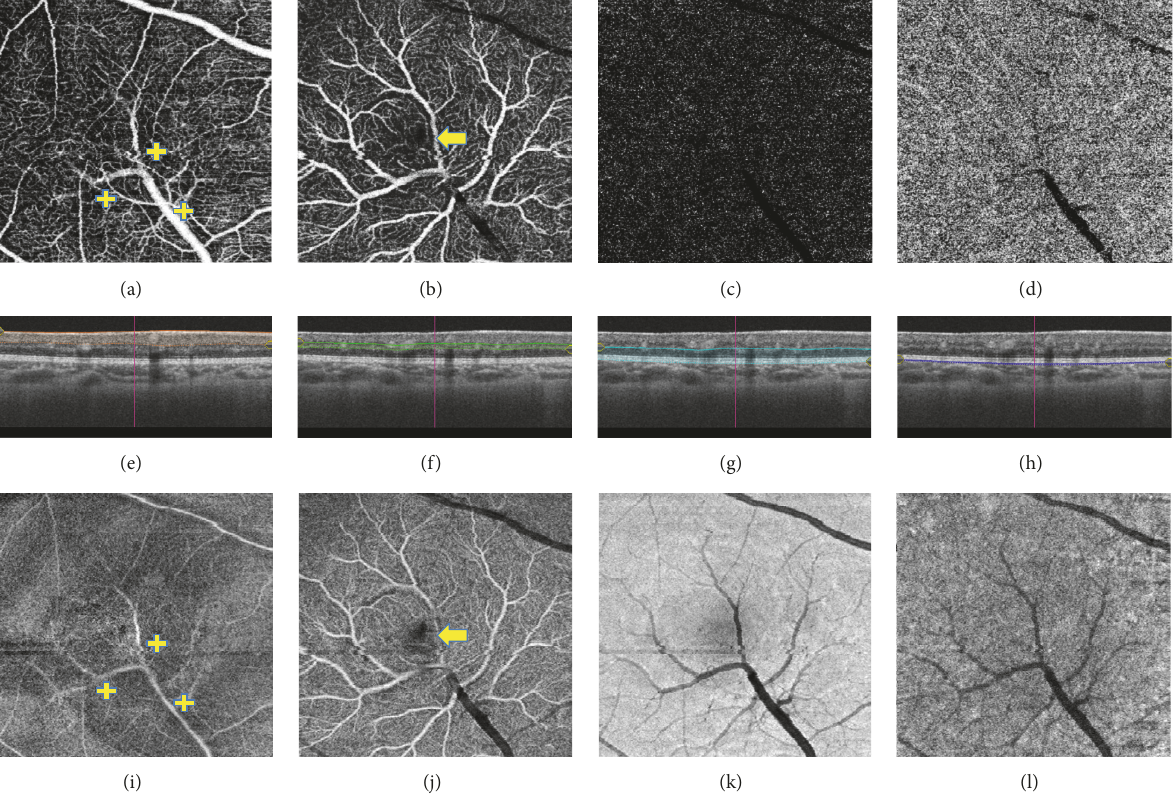
Figure 2: Swept-source OCT angiography (a, b, c, and d) with corresponding segmentation B scan (e, f, g, and h) and en face OCT imaging (i, j, k, and l) of the right eye of a 12-year-old patient with congenital retinal macrovessel (a, e, and i). At the level of the superficial capillary plexus the principal stem of the macrovessel and two main bifurcations are noted (+). Microvascular interconnections obliterate the foveal avascular zone (a). Corresponding SS-en face OCT does not indicate any leakage from the macrovessels (b, f, and j). At the level of the deep capillary plexus there are multiple branches emanating from the principal stem and the bifurcations directed at the level of the outer plexiform layer. The latter extend and bifurcate further horizontally prior to fusing with the capillaries of the deep vascular plexus. The remaining foveal avascular zone is also depicted (arrow), considerably reduced in extent. En face OCT also clearly demonstrates the aberrant vasculature and no evidence of leakage at this level. Scans at the level of outer retina (c, g, and k) and choriocapillaris (d, h, and l) demonstrate projection artefacts of major vessels without evidence of coexisting